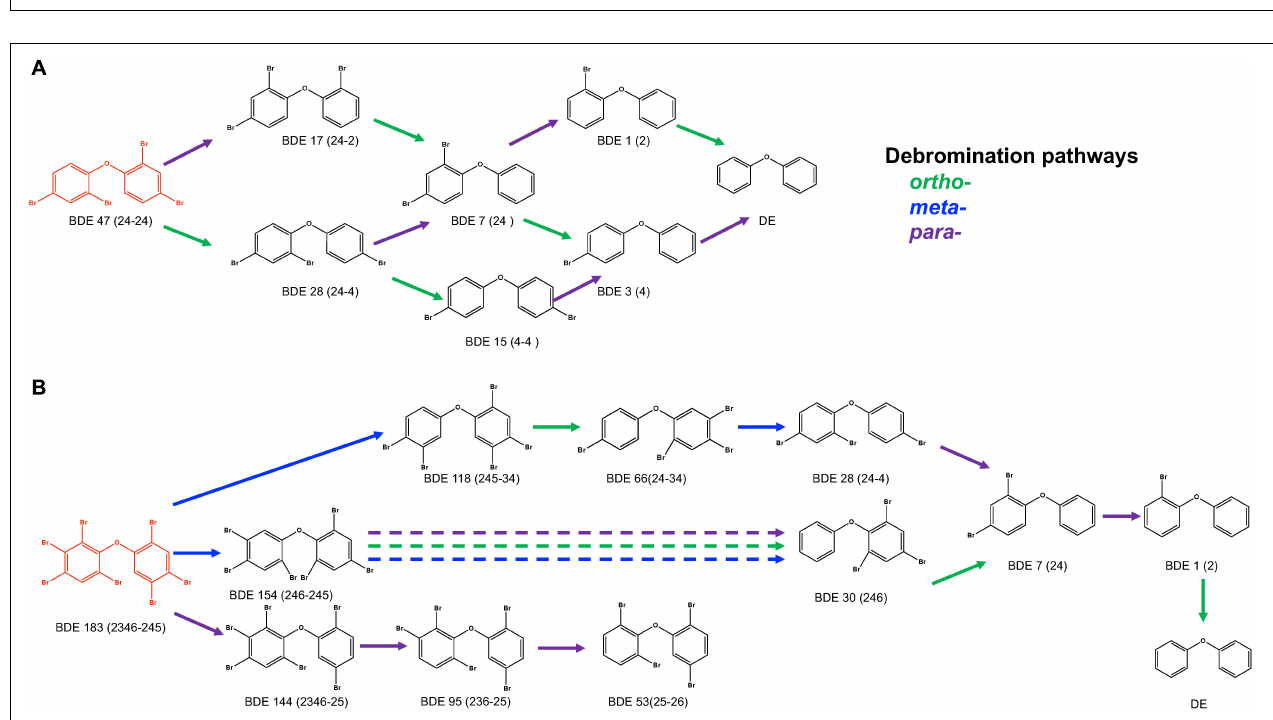
FIGURE 2 | Debromination pathways of tetra-BDE 47 and hepta-BDE 183 by PB enrichment culture. DE, diphenyl